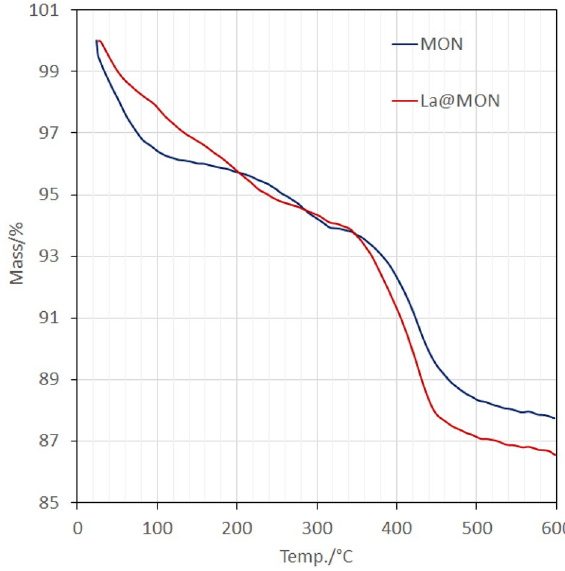
Figure 6. thermogravimetric patterns for MON and La@MON.